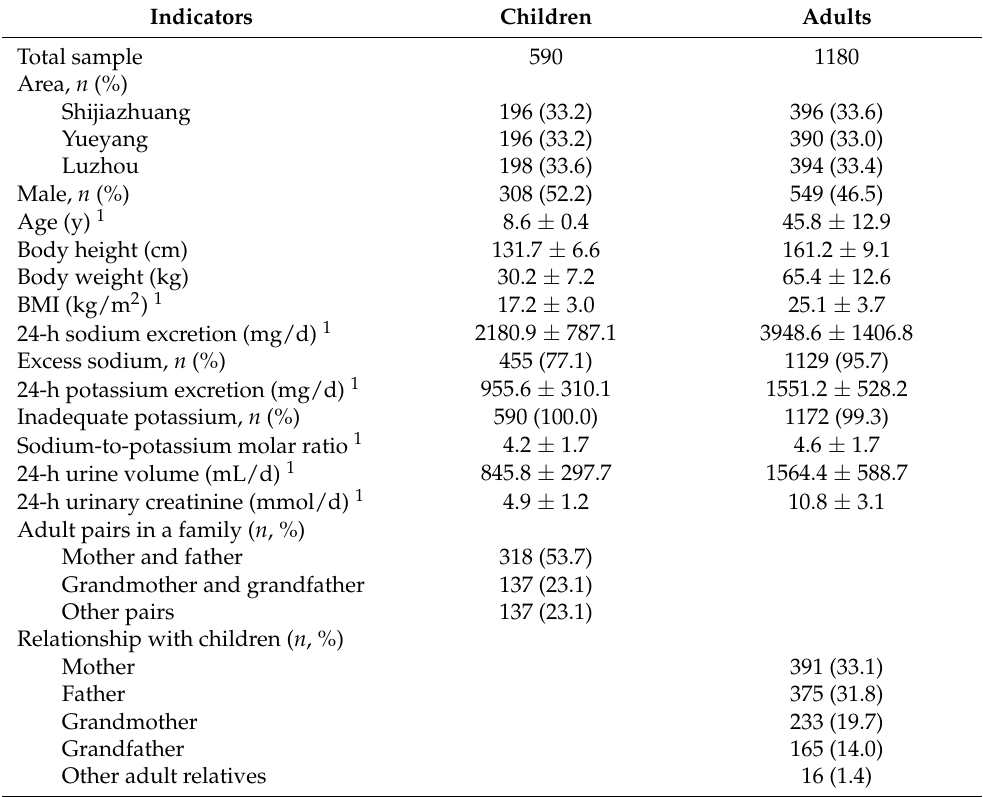
Table 1. Characteristics of children and adult participants.